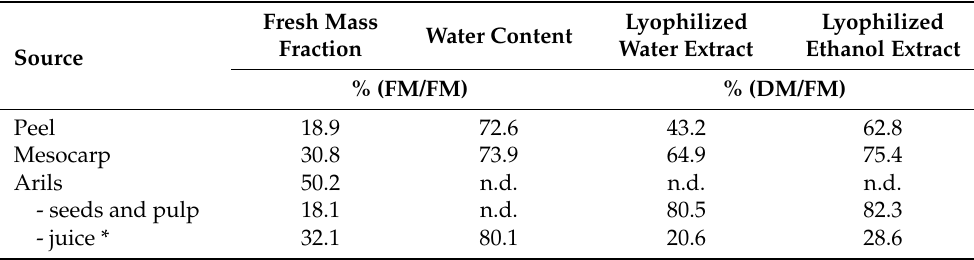
Table 2. Fresh mass, water content, and obtained lyophilized water and 70% ethanol extracts of the pomegranate peel, mesocarp, and arils (before and after juicing).